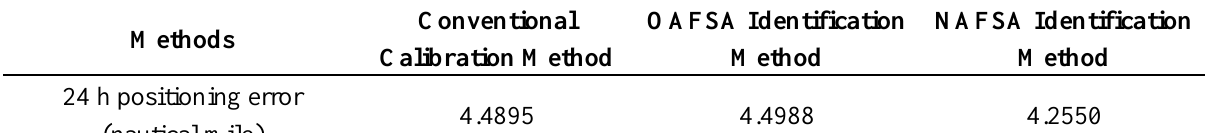
Table 5. Static positioning results of three different methods.